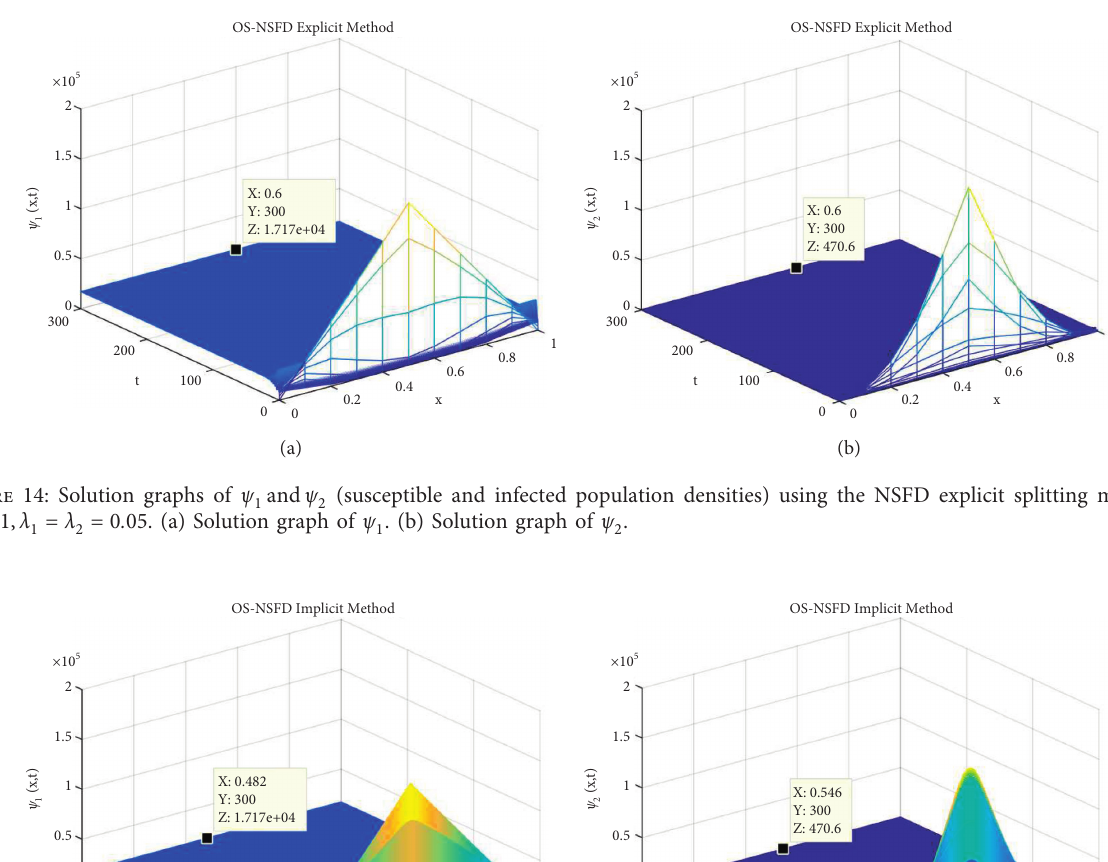
and ψ (susceptible and infected population densities) using NSFD implicit splitting method at 1 2 . (b) Solution graph of ψ 1